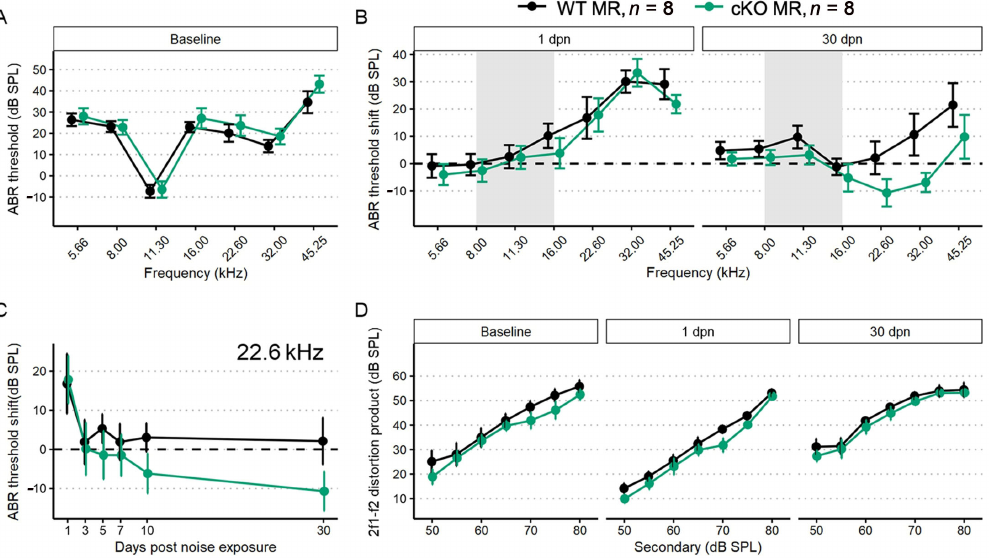
Figure 3. ABR threshold and DP amplitudes (mean ± SEM) from five-month-old mice ( n = 8 each group) after supporting cell MR ablation and 100 dB SPL mild noise exposure. ( A ) Baseline ABR threshold frequency tuning curve. Data from cKO MR mice are green. Ablation of MR did not result in a significant change to baseline thresholds. ( B ) ABR threshold shift plots for 1 and 30 dpn. A threshold shift of zero indicates a full return to pre ‐ noise threshold and would be indicated by a plot along the dashed line. While at 1 dpn there was no difference in threshold shift between MR control (no tamoxifen) and cKO mice, by 30 dpn, cKO mice demonstrated a trend toward more sensitive ABR thresholds at frequencies mapped basal of the region directly impacted by noise. ( C ) ABR